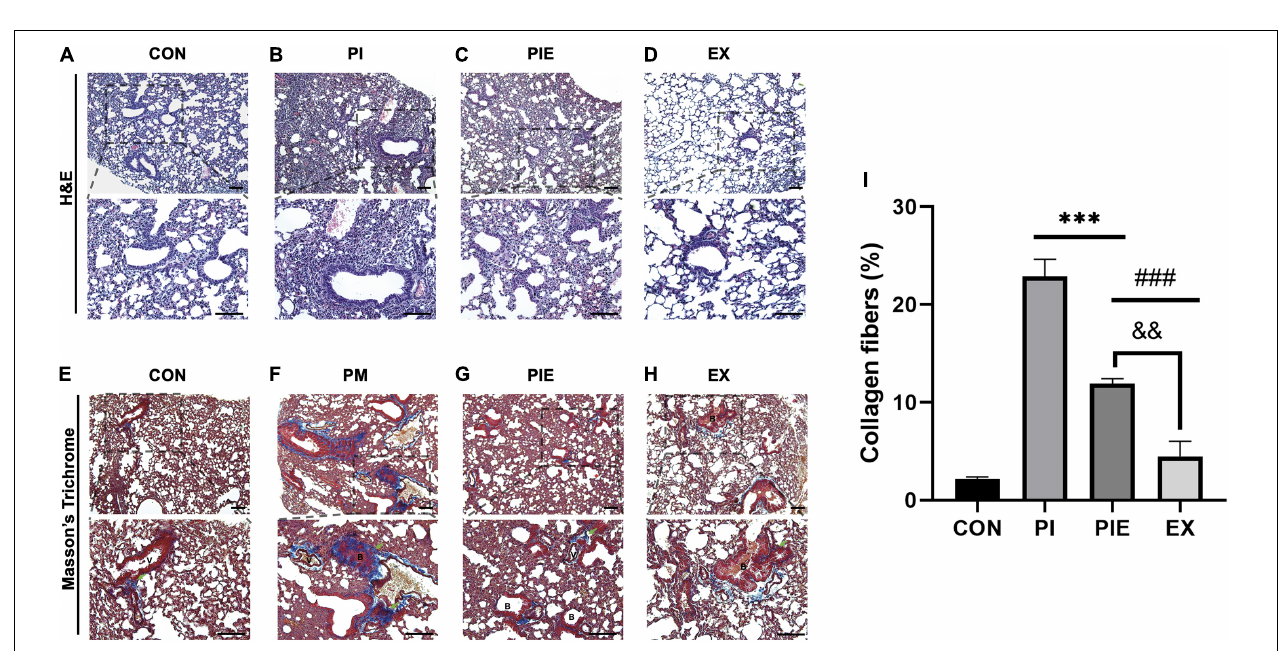
FIGURE 8 | Histochemical and biochemical analyses of the lung fibrosis. (A–D) Hematoxylin and eosin straining of the lung tissue sections. (E–H) Masson’s trichrome (MT) staining of the lung tissue sections, with collagen fibers are shown in blue. Green arrows indicate collagen fibers. (I) Quantification of the collagen fibers observed in MT-stained lung tissue sections. B, bronchiolar; V, pulmonary capillary. Values are the means ± SEM ( n = 3). ∗∗∗ P < 0.001 vs. CON, ### P < 0.001 vs. PI, && P < 0.05 vs. PIE.